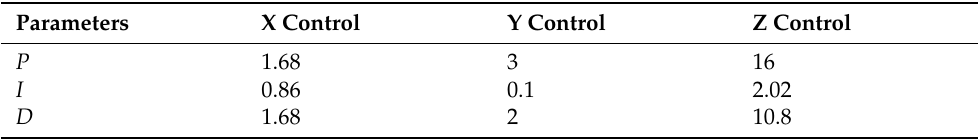
Table 2. Controller values used for the